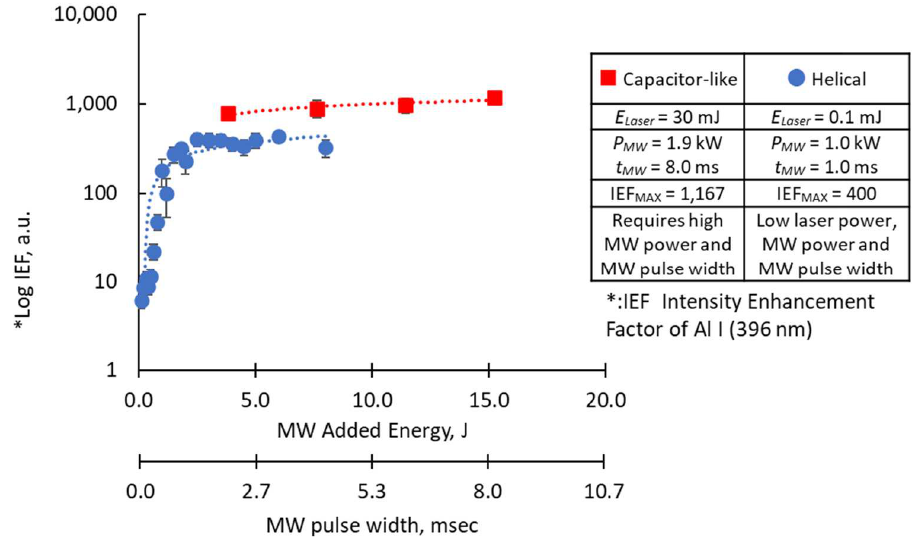
Figure 8. Comparison of the enhancement factors of the Al I (396 nm) emission peak when using the capacitor-like [9] and the helical antenna. The Al I signal is derived from the emission spectra of the Al 2 O 3 breakdown plasma.